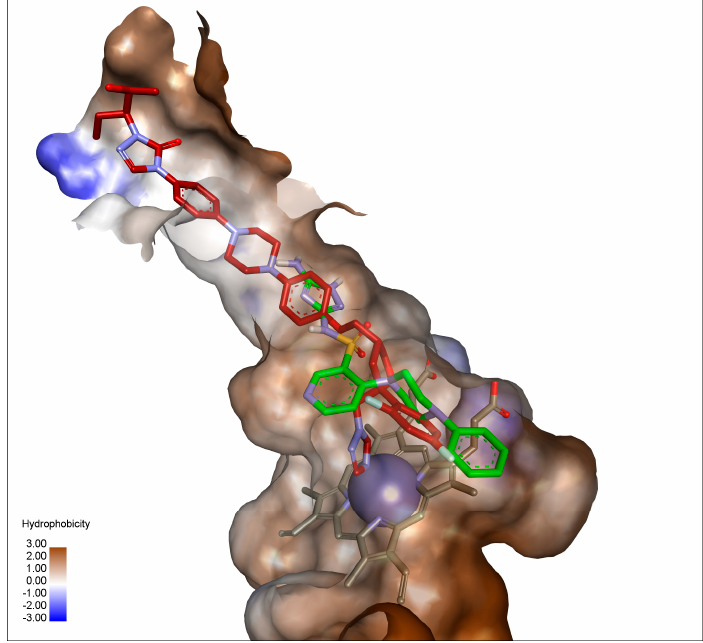
Figure 1. Superimposition of computed binding geometry of compound 26 (green) and conformation of co-crystallized ligand posaconazole (red) inside the solvent accessible surface of CYP51 active site.